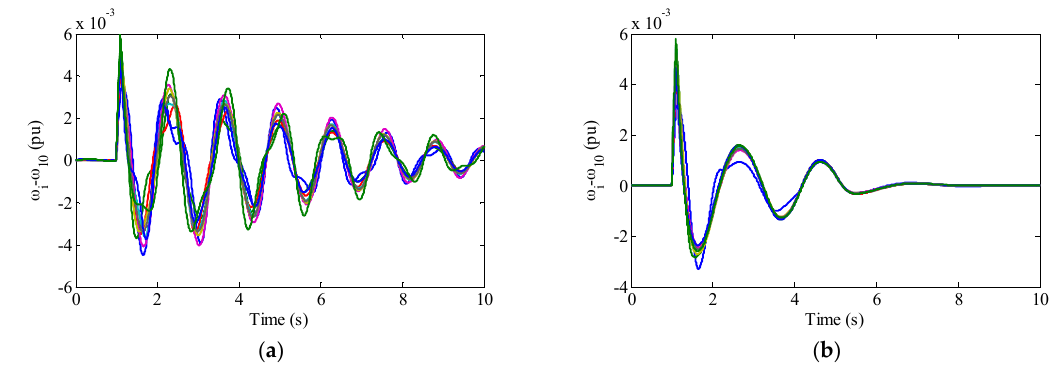
Figure 11. Rotor speed ω i - ω 10 response against a short circuit under operating condition 1. ( a ) Conventional PID governor controller; ( b ) Nonlinear synergetic governor controller.